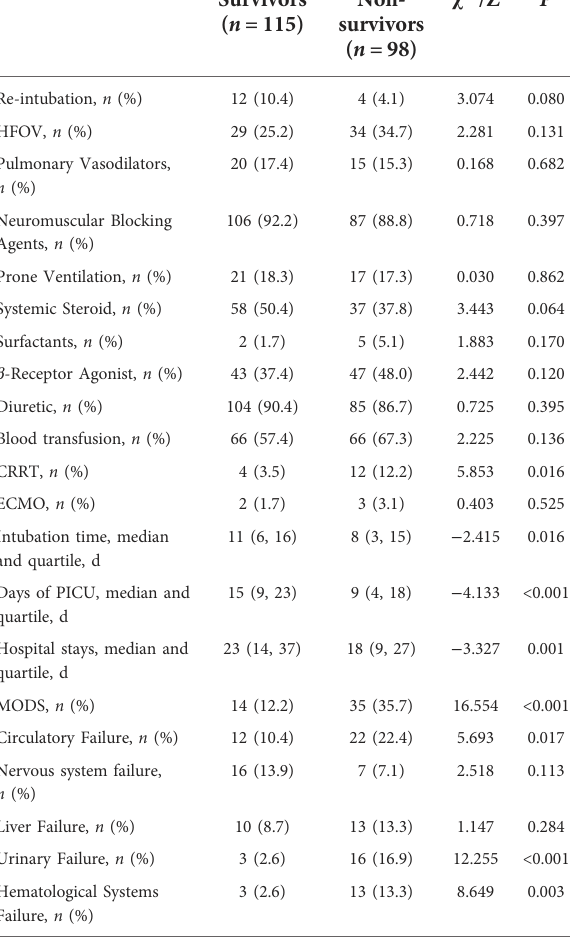
TABLE 2 Treatment information and outcomes. TABLE 3 Univariate logistic regression